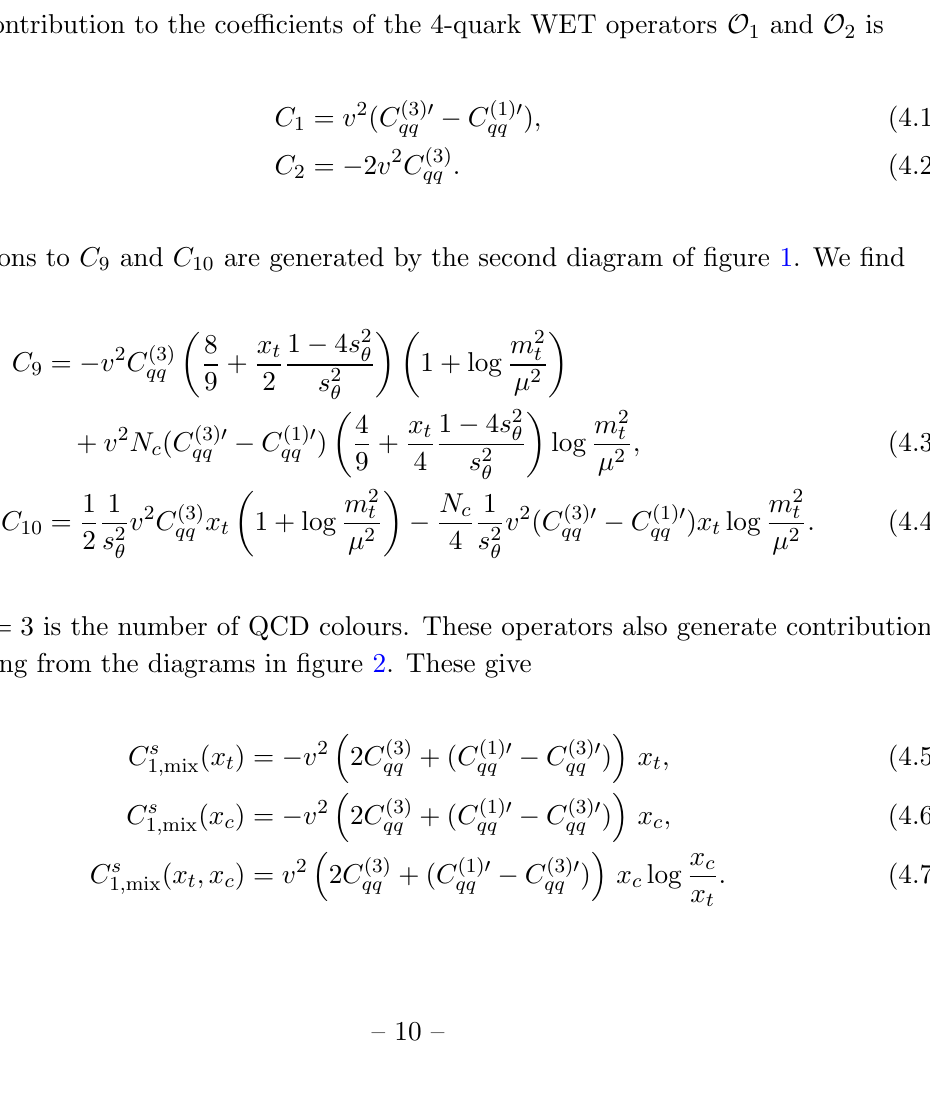
(all four diagrams and lq